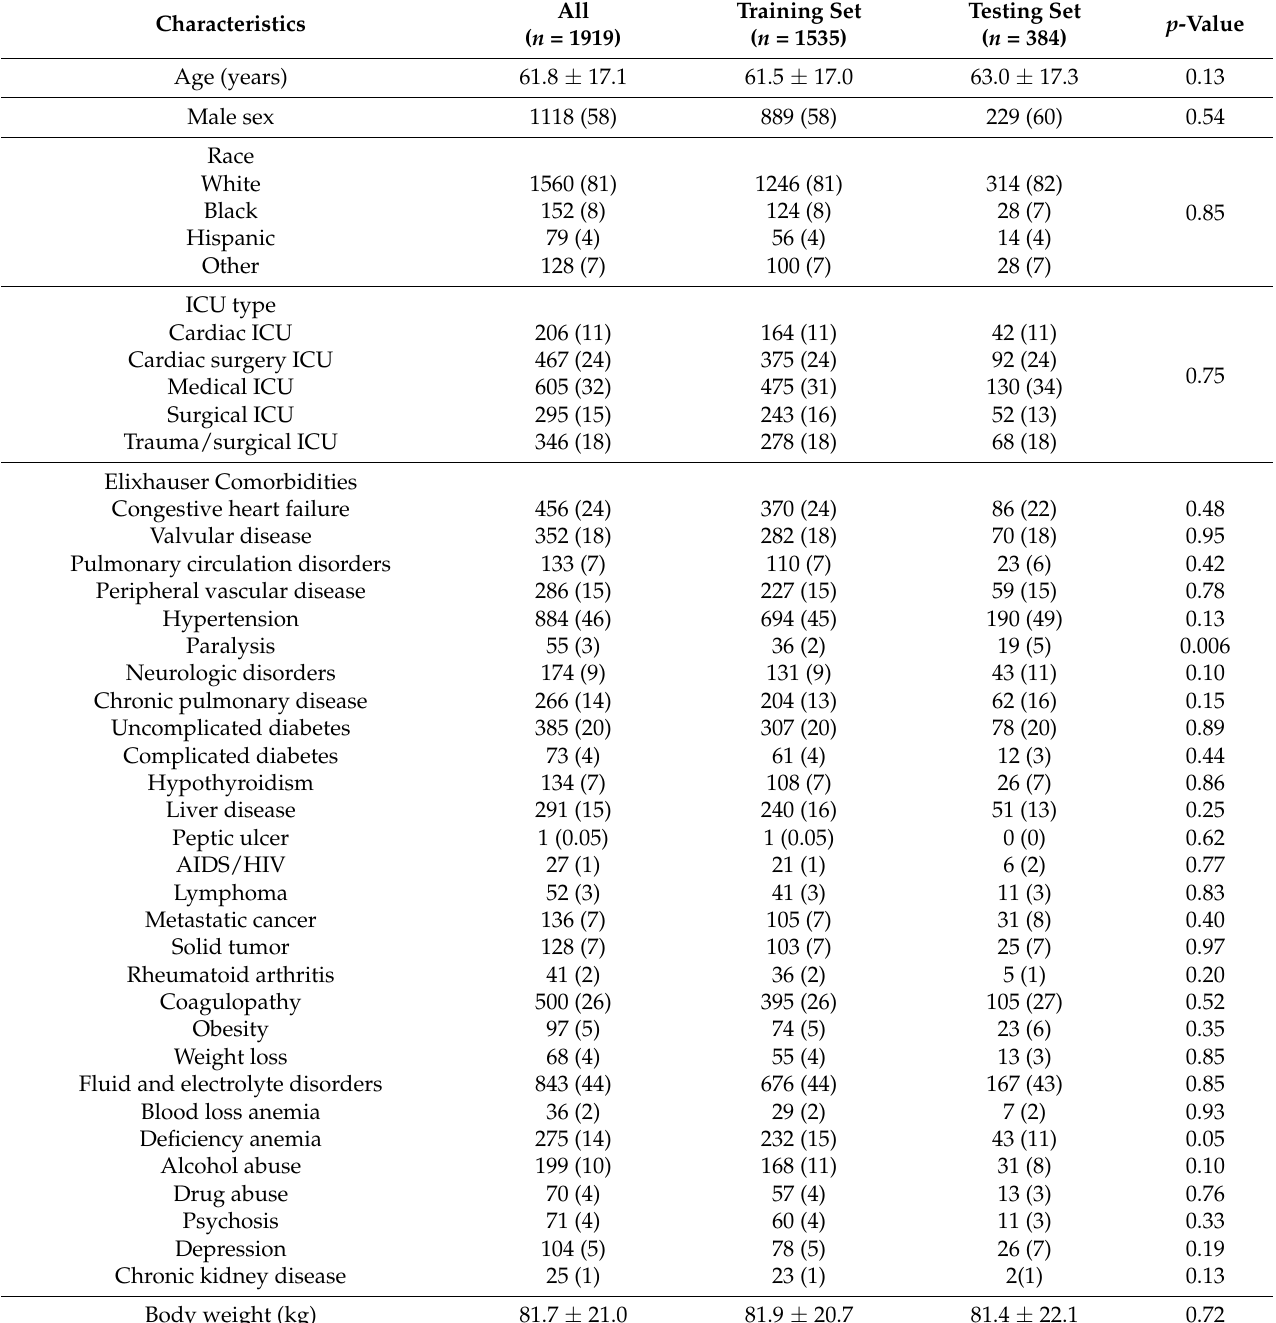
Table 1. Patient characteristics in the training and testing